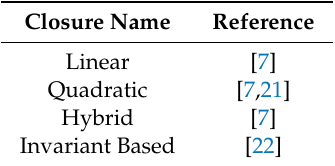
Table 3. List of closures for sixth-order fiber orientation